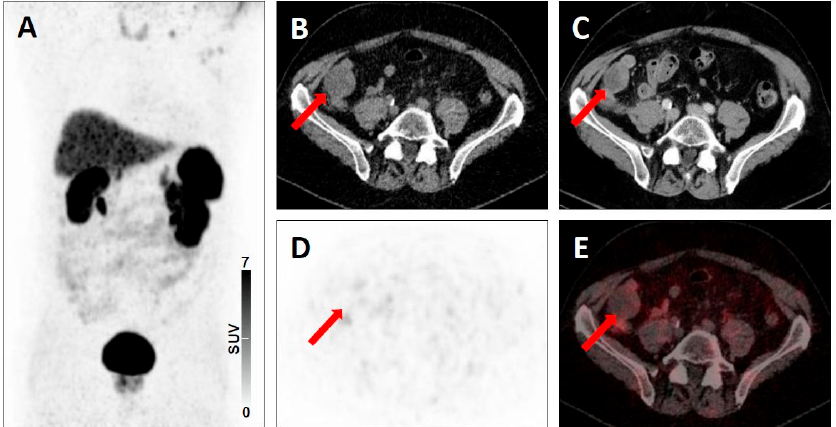
Figure 6. Lesion suggestive of malignancy on anatomic imaging but lacking uptake on SSTR-targeted positron emission tomography (PET)/computed tomography (CT). 68 Ga-DOTATATE PET/CT for restaging in a 67-year-old man with a history of pancreatic neuroendocrine carcinoma. Whole-body maximum intensity projection image with no evidence of disease ( A ). Axial low-dose CT ( B ), contrast-enhanced CT ( C ), PET ( D ), and fused PET/CT ( E ) showing a peritoneal lesion suggestive of malignancy on anatomic imaging, but lacking uptake (red arrows), consistent with a SSTR-RADS-3D lesion.